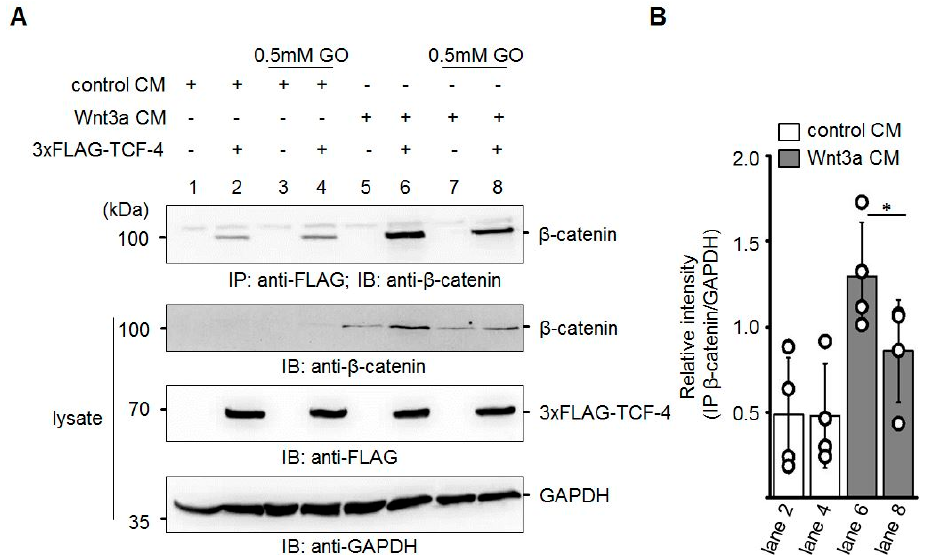
Figure 6. Reduced binding of β -catenin to TCF-4 after GO-treatment of Wnt3a CM. ( A ) Neuro-2a cells were transiently transfected with 3xFLAG-TCF-4 and subsequently treated with the indicated CM. After immunoprecipitation (IP) with anti-FLAG antibody, the amount of co-precipitating β -catenin was analyzed by immunoblotting (IB). The presented blot is a representative of n = 4 independent experiments. ( B ) Quantification of Western blot experiments. Signal of co-immunoprecipitated β -catenin was normalized to GAPDH in the lysates. The graph shows mean values ± SD. Circles represent individual experiments. Data were analyzed with a paired t-test. * p <